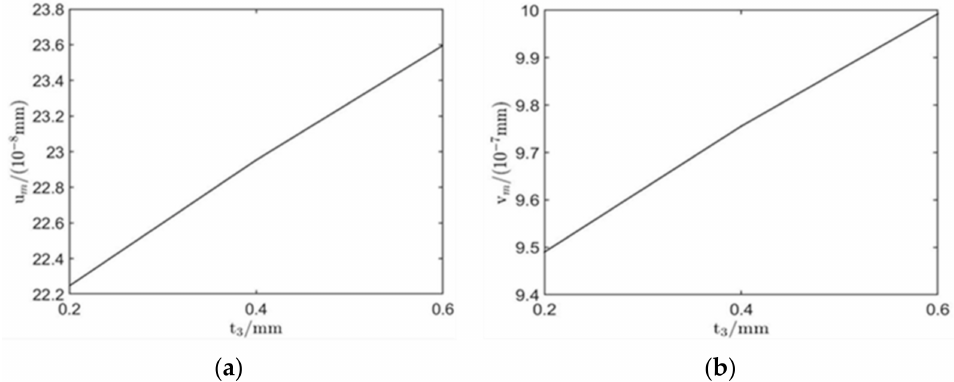
Figure 9. The influence on surface wave amplitude by changing the thickness. ( a ) Amplitude of in-plane displacement and ( b ) amplitude of out-of-plane